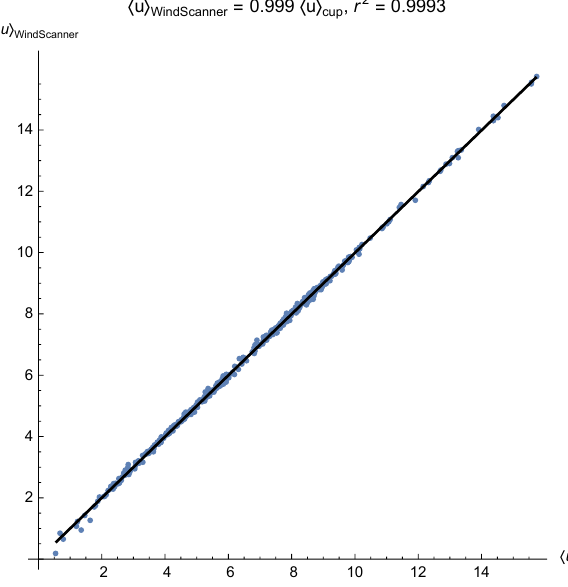
Figure 3. Location of the Høvsøre test centre in Denmark (inset) and details of the site, where the location of the WindScanner and the met masts are shown.